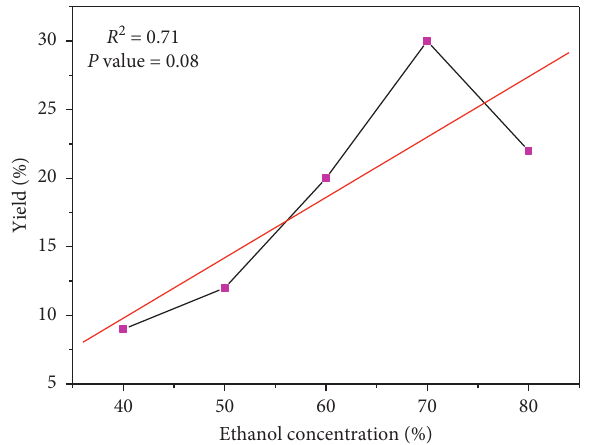
Figure 2: Effects of ethanol concentration on yield of extraction.